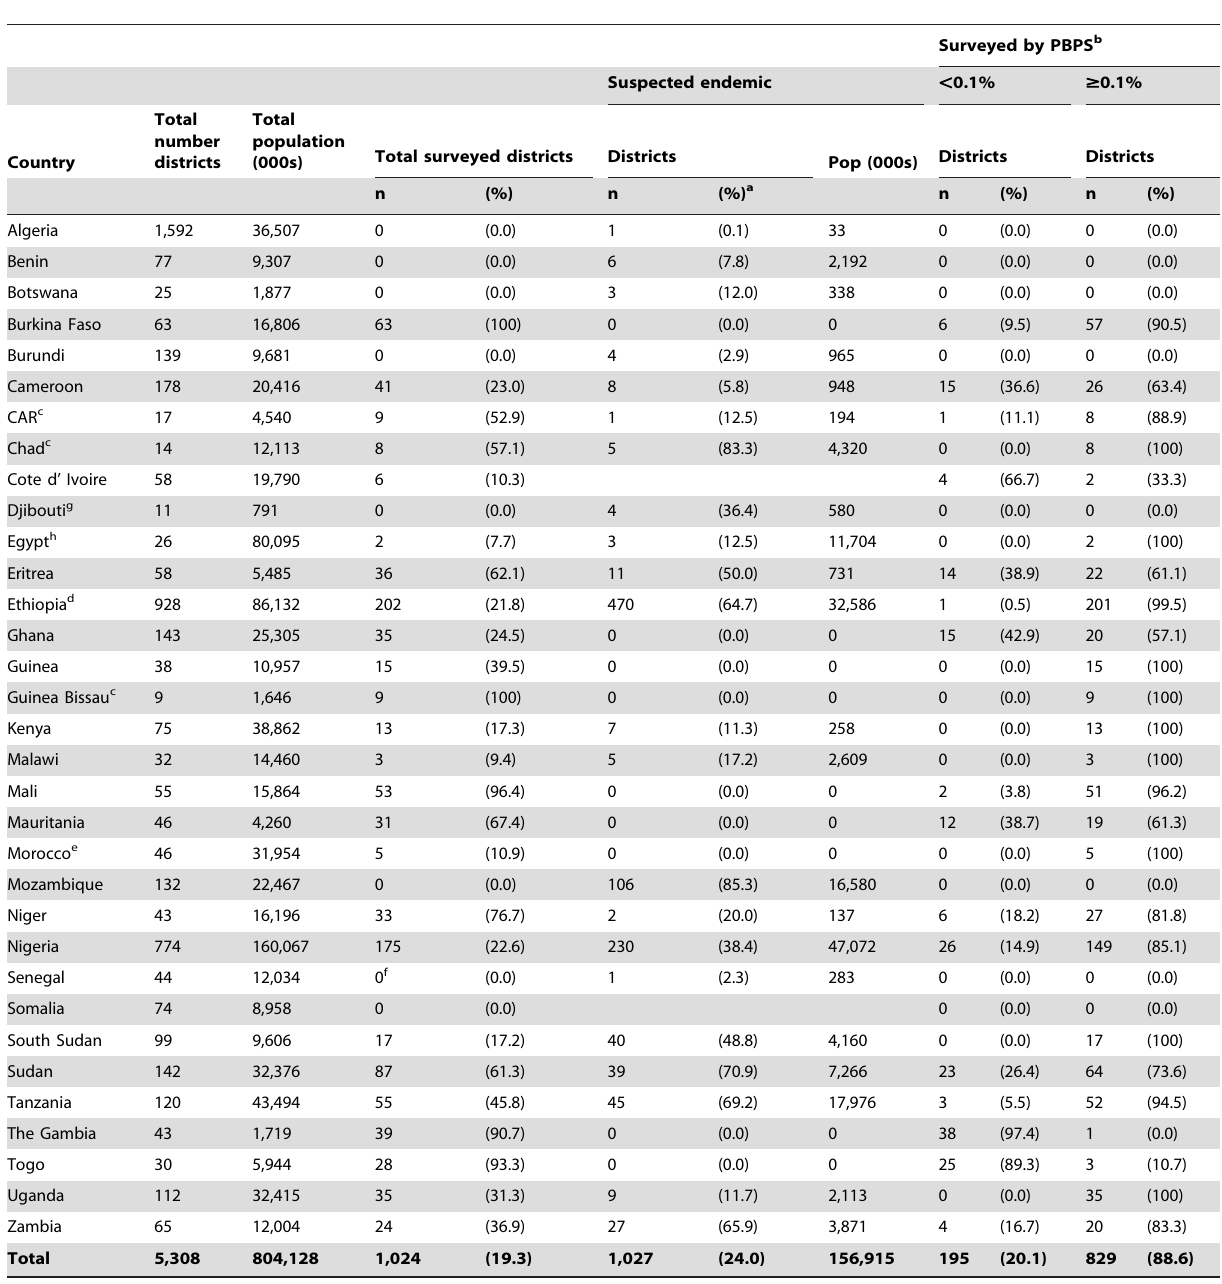
Table 4. District estimates in each endemic category of trichaisis (TT) and availability of current district level data from population based prevalence surveys (PBPS) in Africa in adults aged greater than 15